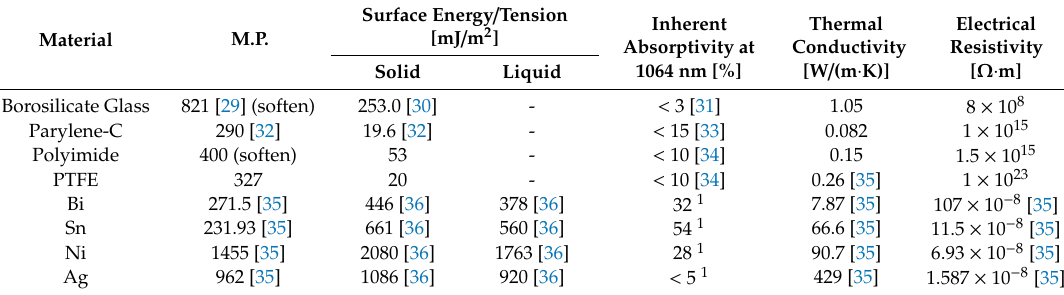
Table 1. Physical attributes of various substrate or target film